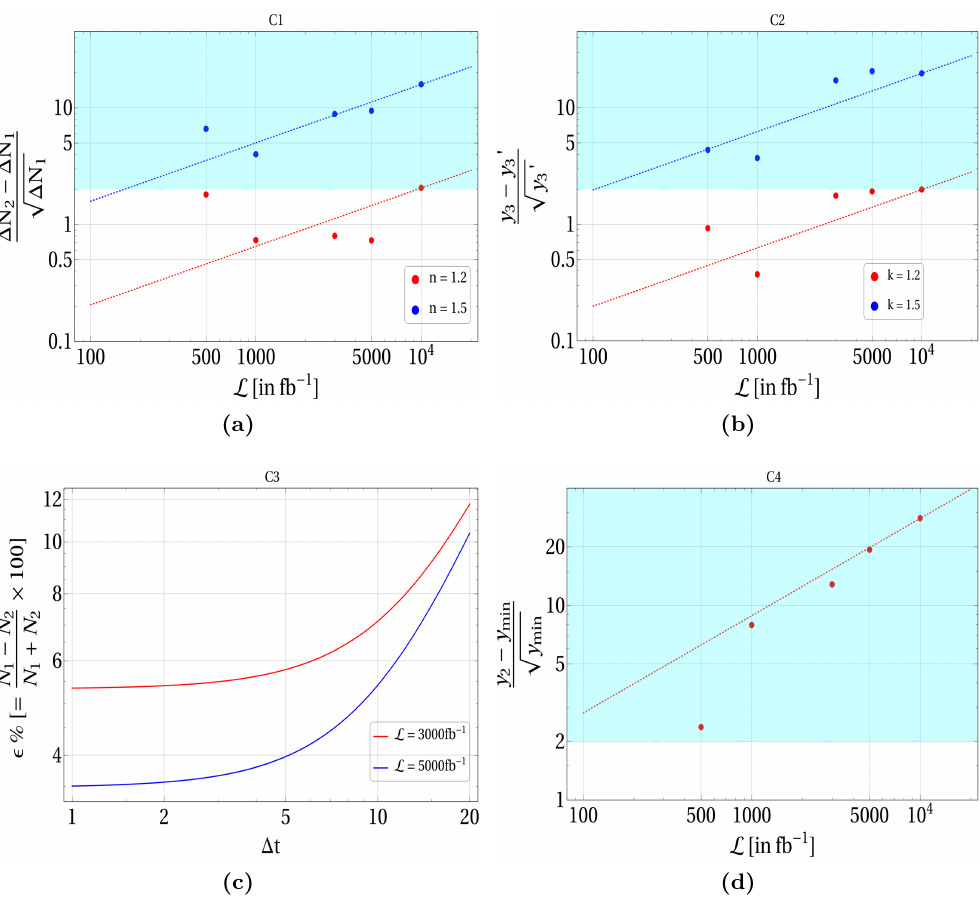
Figure 19. Statistical conditions to distinguish the two peaks for BP1: (a) R C 1 as a function of L for different n (defined in equation (7.4)), (b) R vs L for different k (defined in equation (7.5)), C 2 (c) R as a function of ∆ t (defined in equation (7.6)) and (d) R vs. L (defined in quation (7.7)). C 3 C 4 Sky blue shaded region indicates R 2 . The dots indicate simulated points whereas the C 1 , 2 , 4 > √ dotted line indicates scaling with integrated luminosity as ∼ L